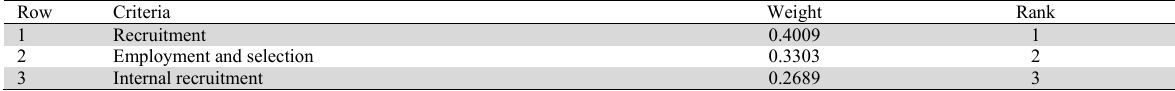
Ranking of recruitment and selection